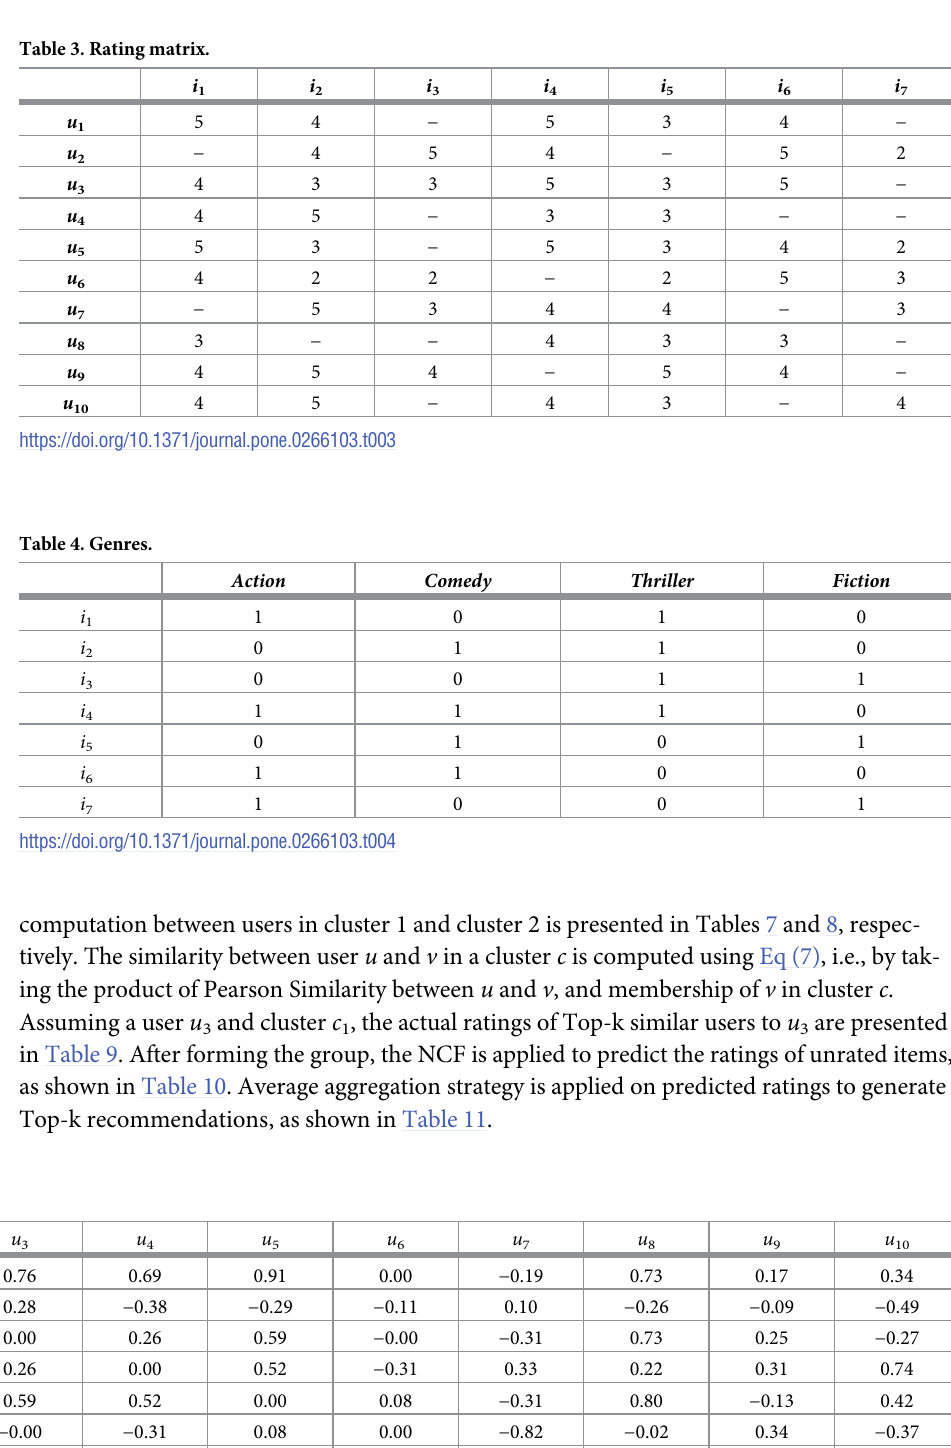
Table 5. Pearson